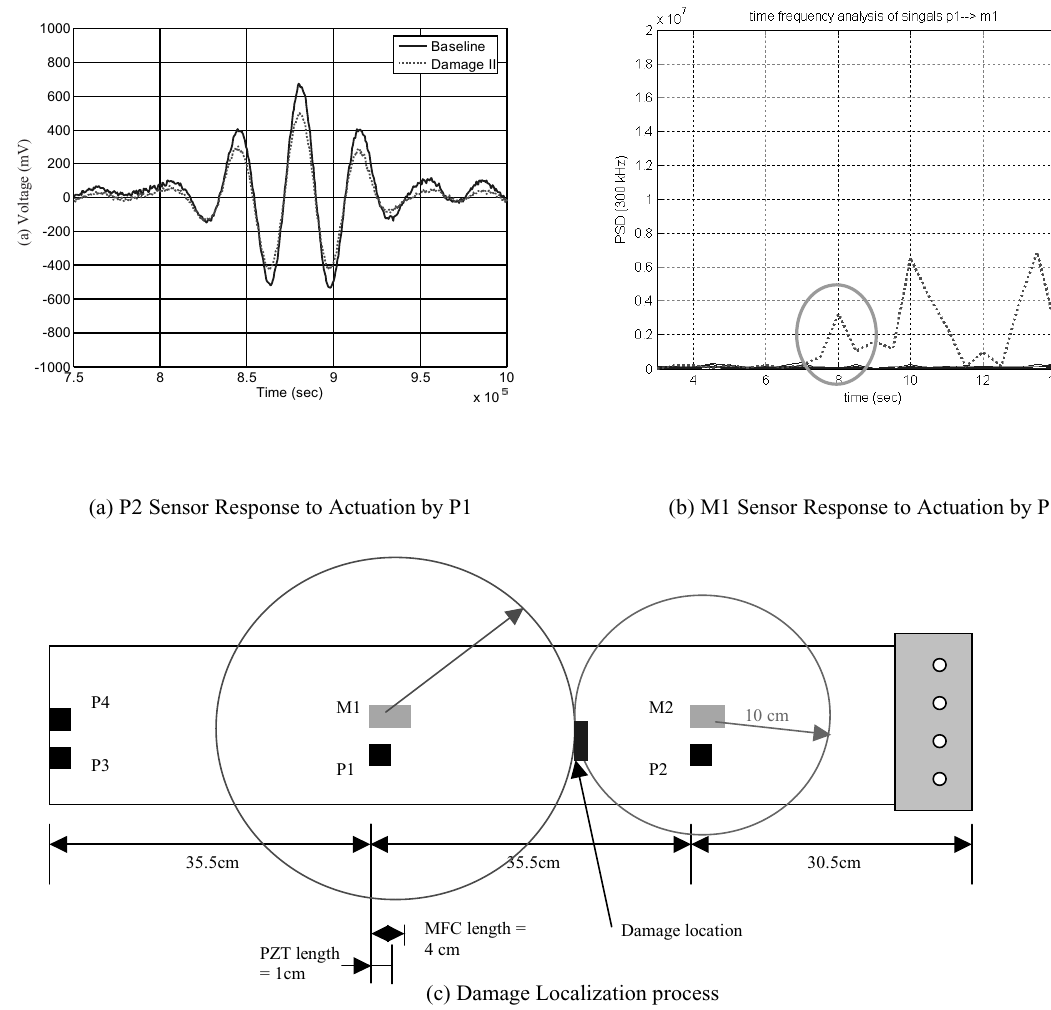
Fig. 14. Damage Localization process for Damage II (a) P2 Sensor Response to Actuation by P1; (b) M1 Sensor Response to Actuation by P1; (c) Damage Localization process. changes [3]. Instead, in this study, the impedance method is used to identify the connection damage only at the clamped-end. Damage is introduced by loosening one of the bolts through the two steel angles. As will be illustrated next, the impedance method shows the extreme sensitivity to joint-connection damage, while the Lamb wave method does not show any comparable